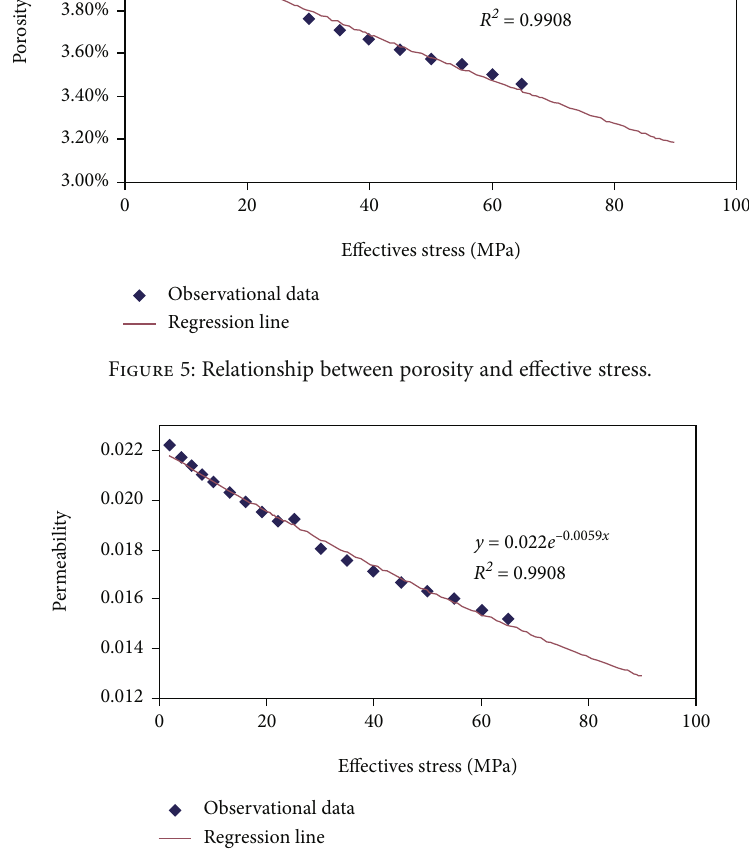
Figure 6: Relationship between permeability and e ff ective